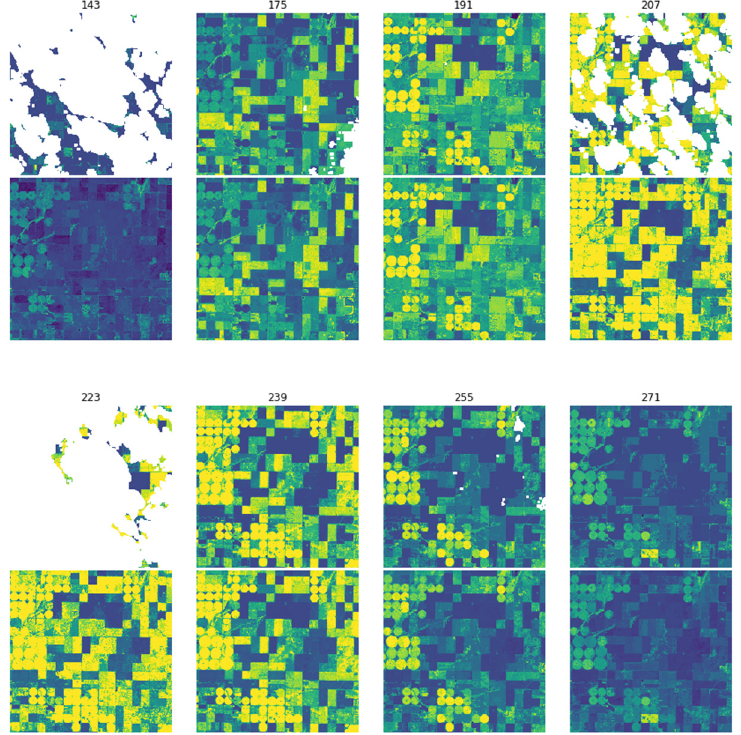
Figure 5. Leaf area index (LAI) visual results of SIM (the upper image of each pair is the input and the lower is the output) at the CSD area for all input days. The blanks and gaps in the upper images in each pair result from the removal of clouds, cloud shadows, and scan line corrector failure. Table 3. Structural similarity measure (SSIM) between input and output LAI images for the CSD area.